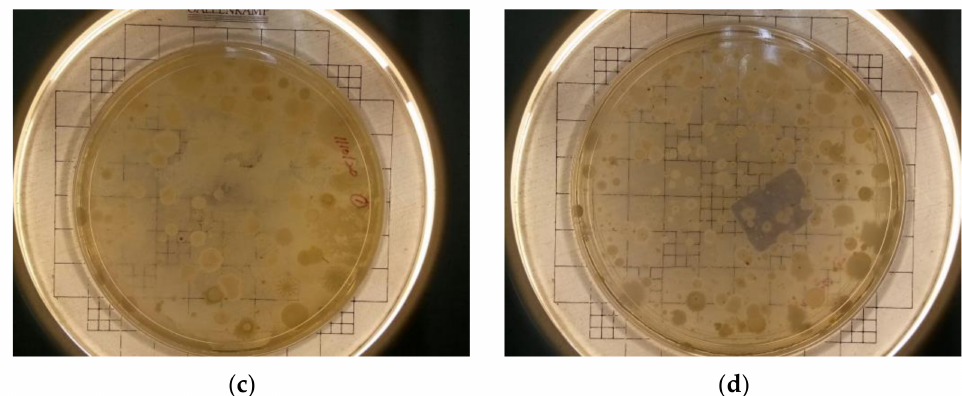
Figure 11. Samples collection after incubation period for blank (gravitational method) from Site 1 ( a ) and Site 2 ( b ) and samples collected using Bio-Culture™ Model B30120 for 5 min at Site 1 ( c ) and Site 2 ( d ) during Rice Straw Burning Activities.